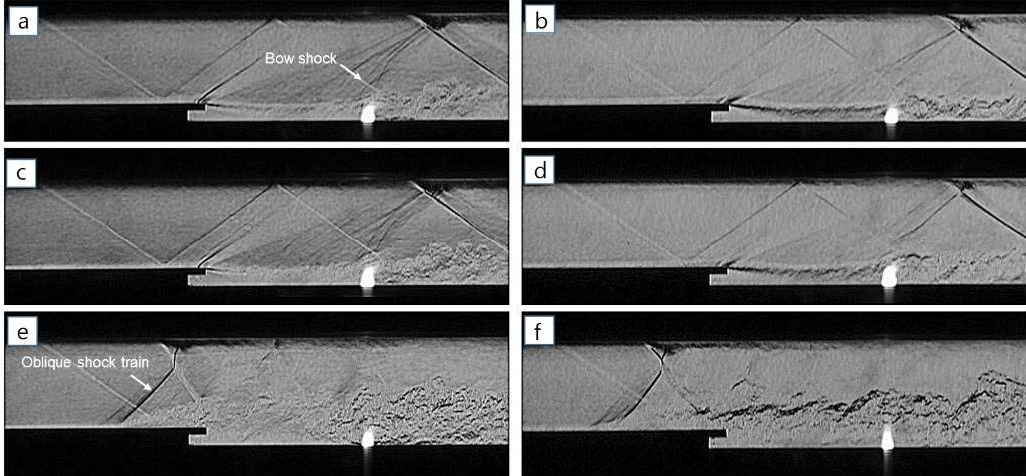
Figure 10. Flow structure transition of the normal 1 injection for ER rise: vent slot mixer ( a , c , e ) and vent circle mixer ( b , d , f ).